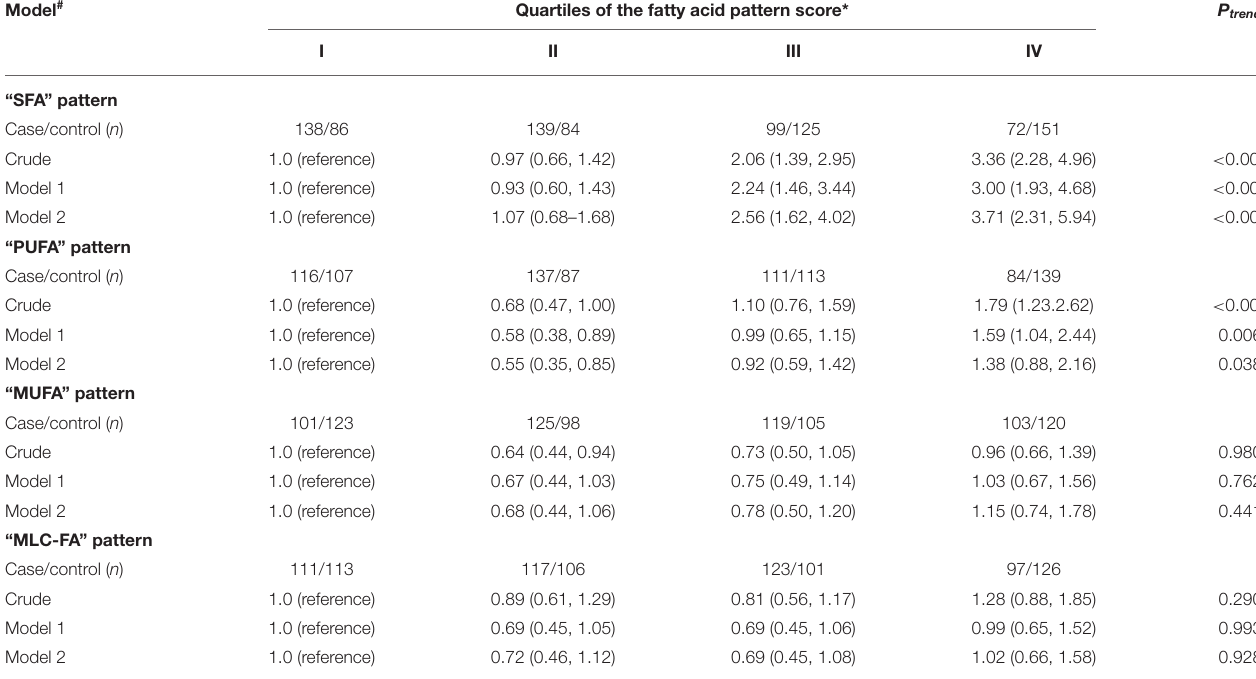
TABLE 3 | Association between fatty acid patterns and oral cancer risk. Model